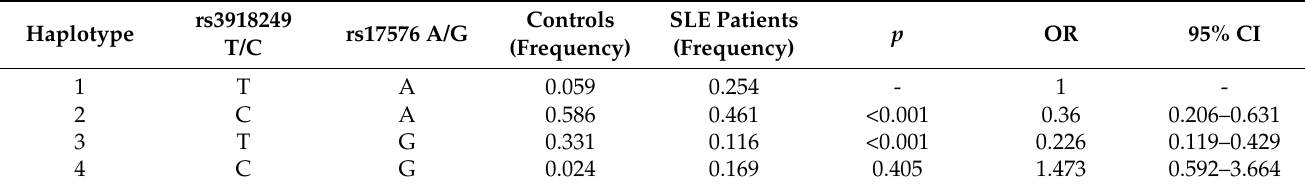
Table 4. Gelatinase B/MMP-9 rs3918249 T/C and rs17576 A/G haplotypes in the studied SLE patients and healthy control